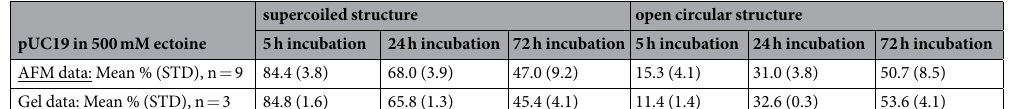
supercoiled structure open circular structure pUC19 in 500 mM ectoine AFM data: Mean % (STD), n = 9 84.4 (3.8)